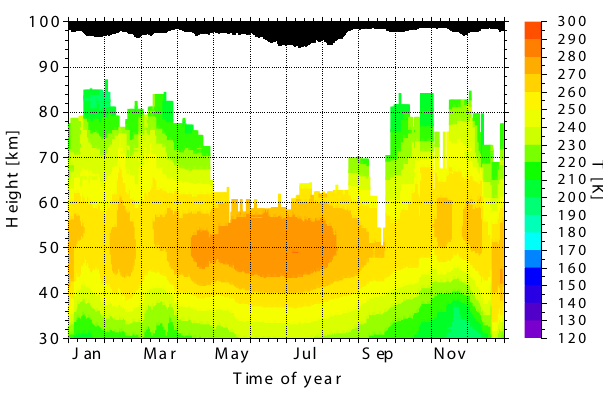
Fig. 4. RMR lidar temperatures from Fig. 3 but now smoothed with a 15-day running-average filter. This gives a better estimate of the mean seasonal temperatures and fills the smaller gaps. No addi- tional smoothing in height has been applied. The black bars are smoothed with the same 15-day